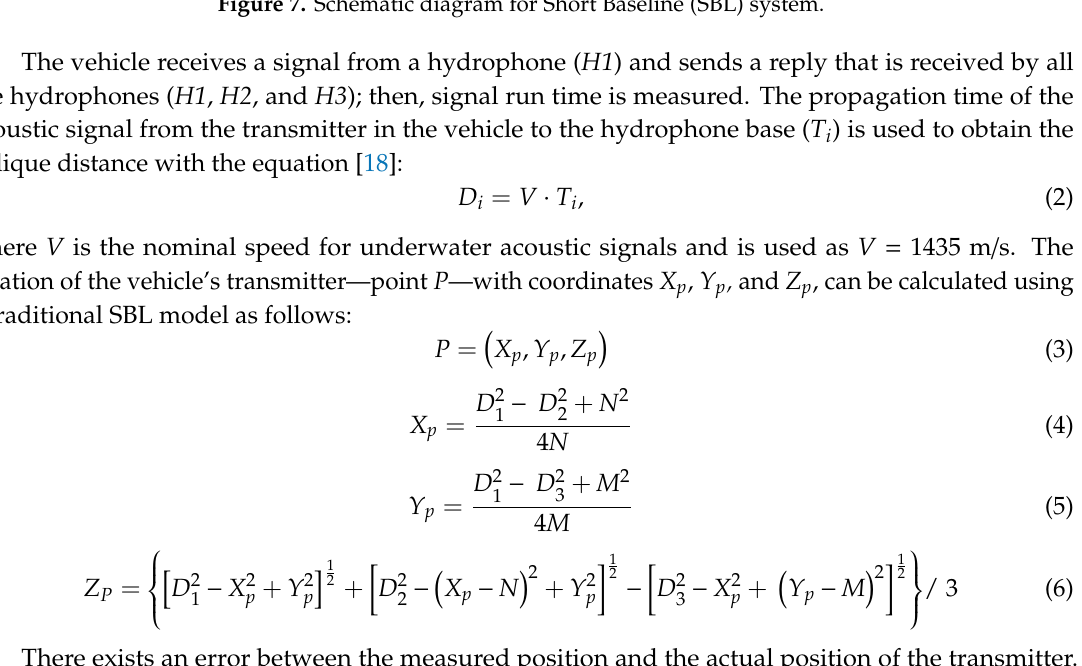
Figure 7. Schematic diagram for Short Baseline (SBL) system.